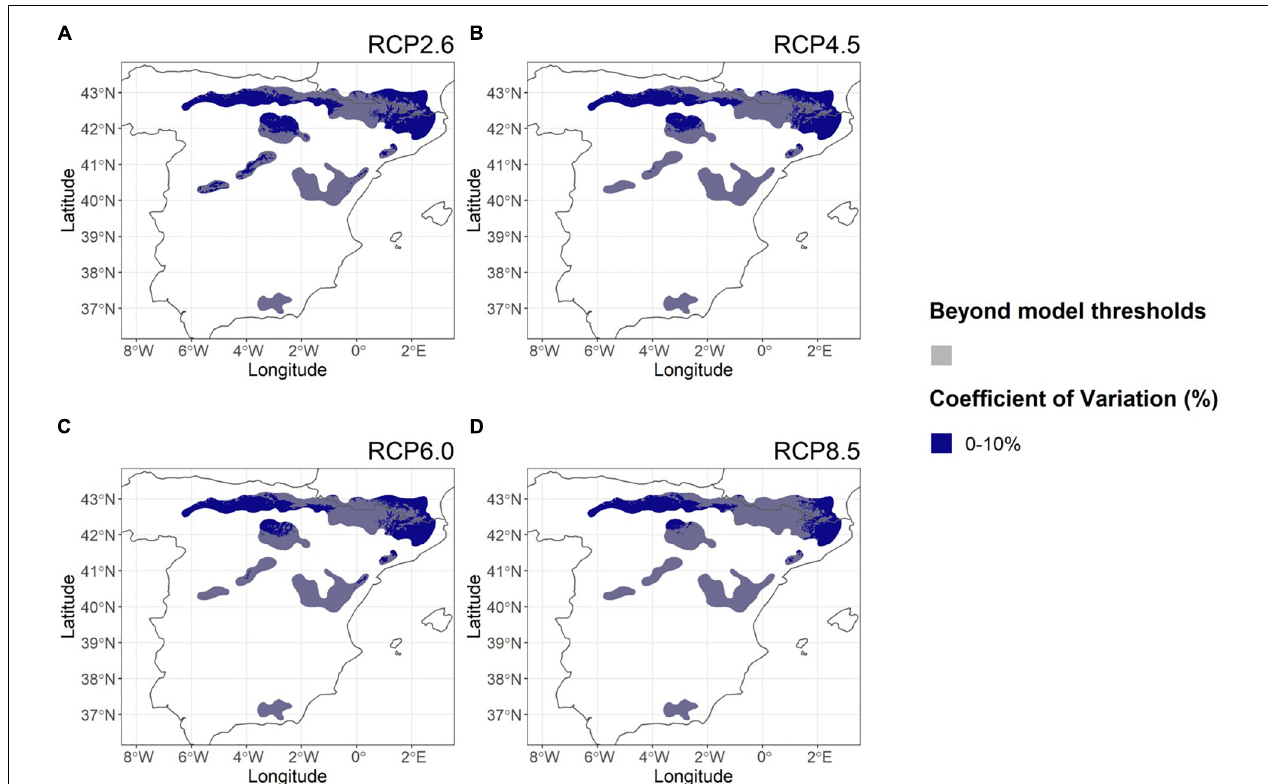
FIGURE 7 | Coefficients of variation (CoV) for Scots pine tree height among available GCMs, calculated for each 1 km × 1 km prediction and for each RCPs 2.6 (A) , 4.5 (B) , 6.0 (C), and 8.5 (D) with Scots pine distribution areas in Spain. All locations where environmental/climate variables exceeded the model data range according to three GCMs have been dimmed in semi-transparent